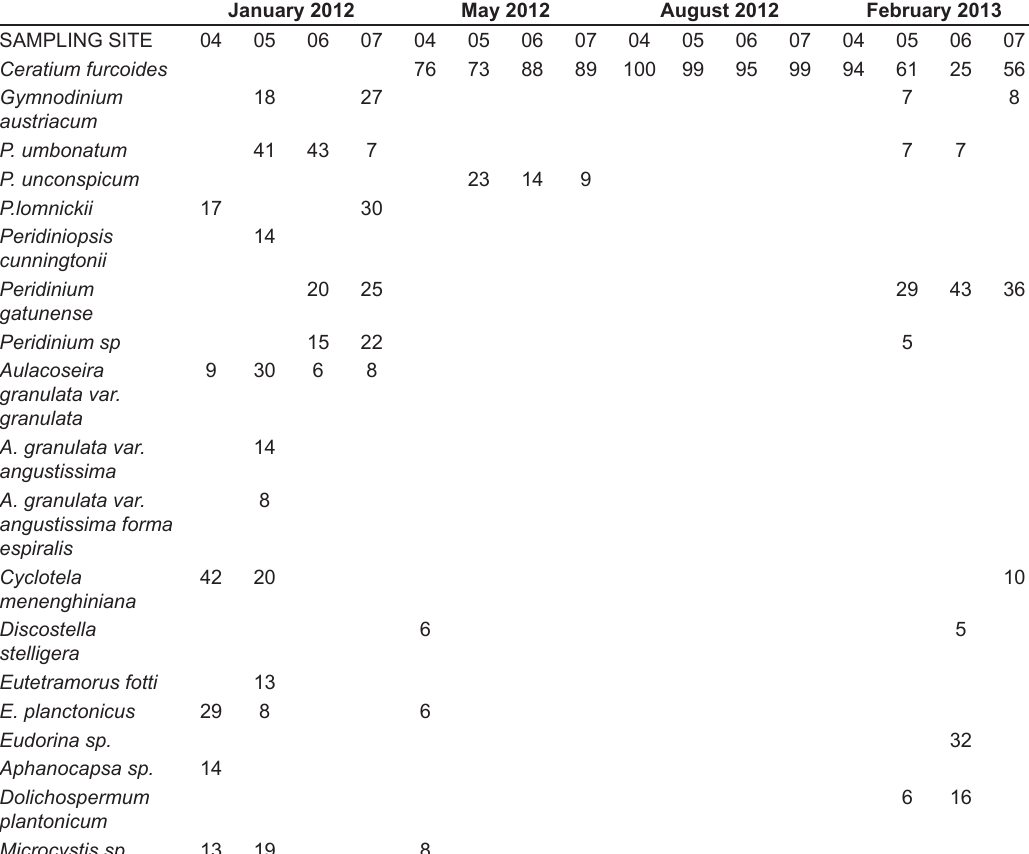
Table 3. Average percentage of biovolume referring to the three depths collected from the phytoplankton community in Itaúba, reservoir